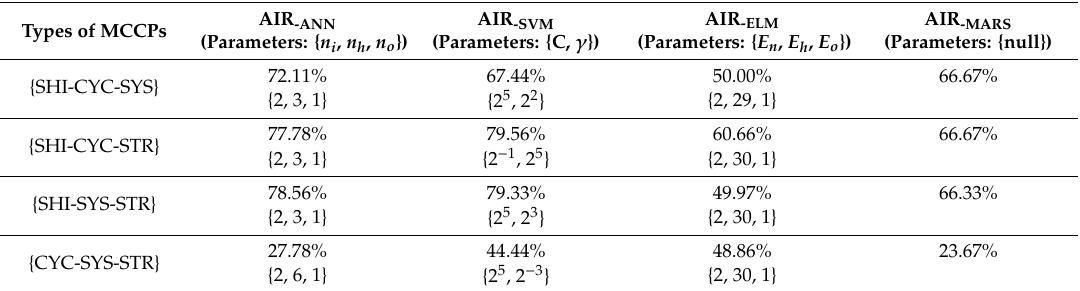
Table 5. Results of MCCP recognition for three process outputs (second scheme: with the use of EPC). Types of